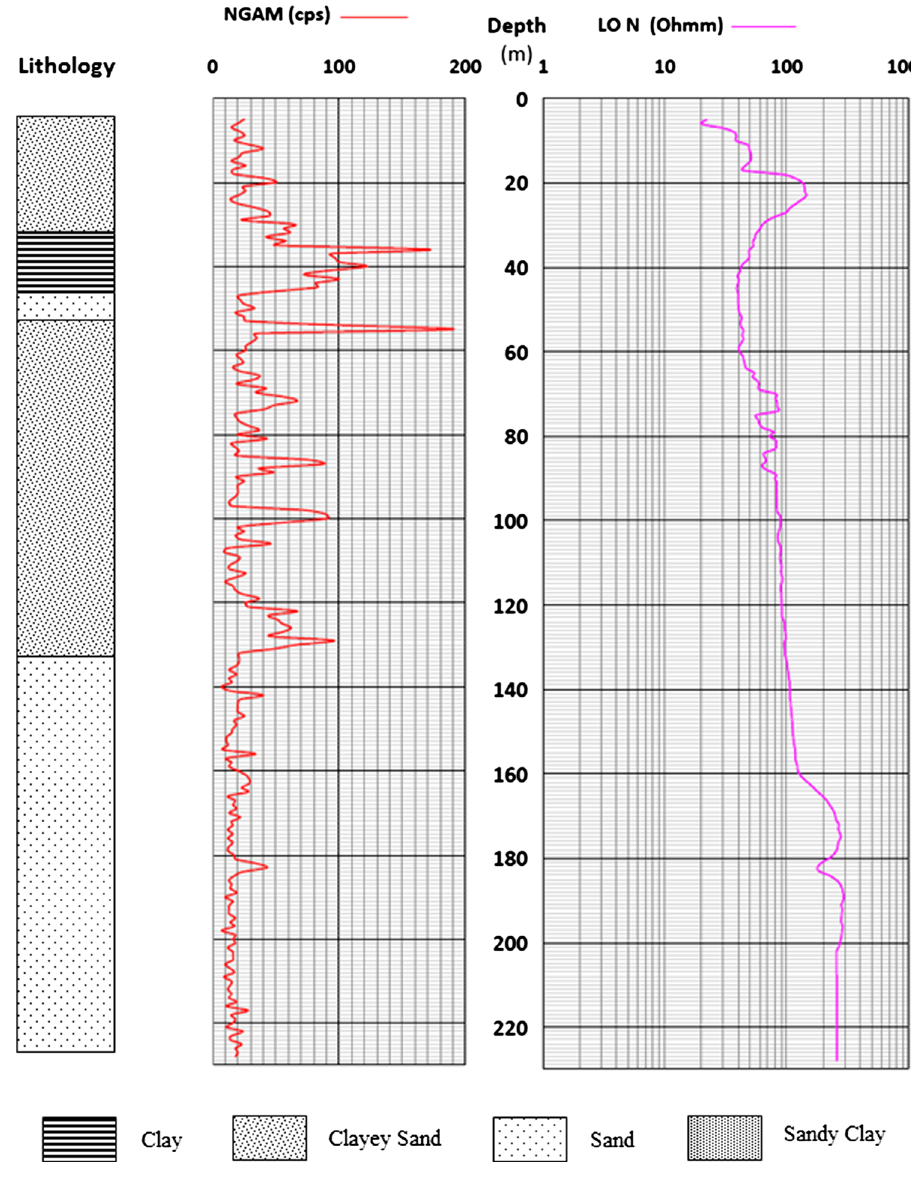
Fig. 5 Digitized lithologic and geophysical borehole logs of BH